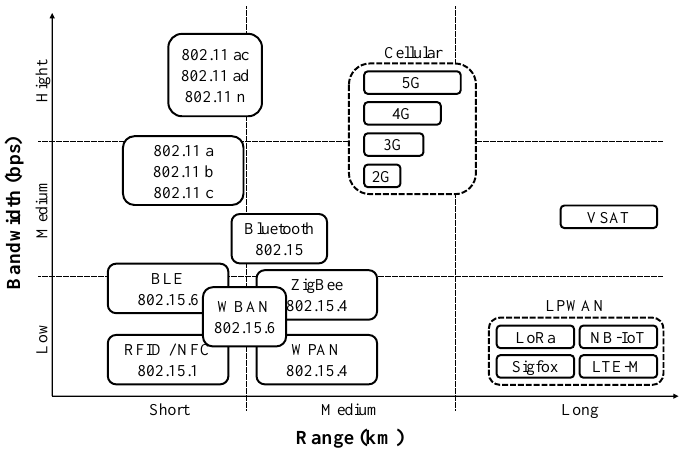
Figure 1. Range of wireless protocols, according to [10] and our own knowledge and